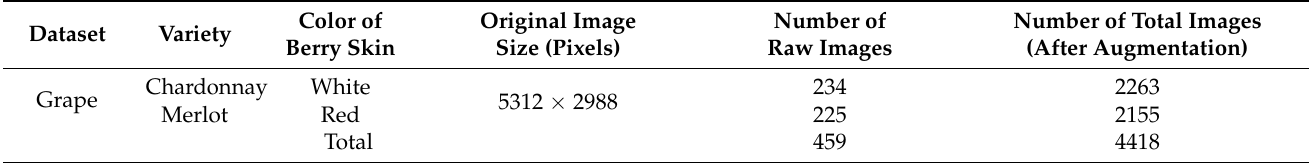
Table 2. Grape imagery dataset and augmentation in this